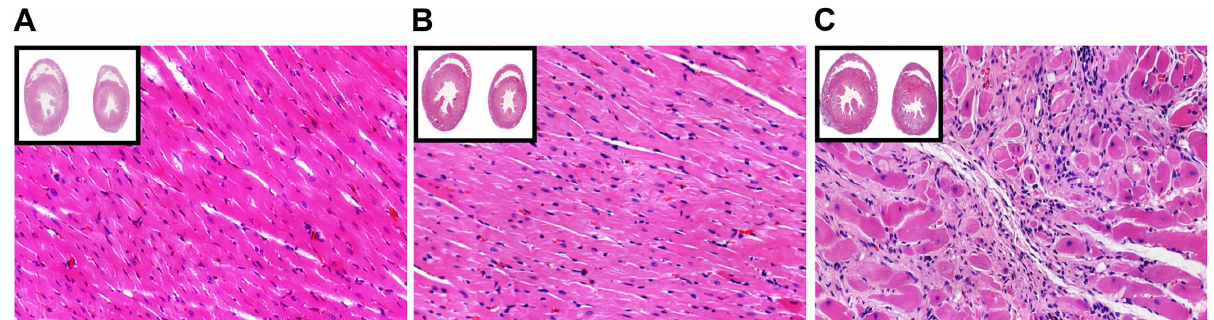
Fig 2. Histopathological changes in heart tissue after acute myocardial infarction (AMI) with hematoxylin-eosin (HE) staining (10X and 20X magnification). (A) HE staining of normalheart tissue. (B) HE staining of heart tissue from the Sham group. (C) HE stainingof heart tissue from the AMI